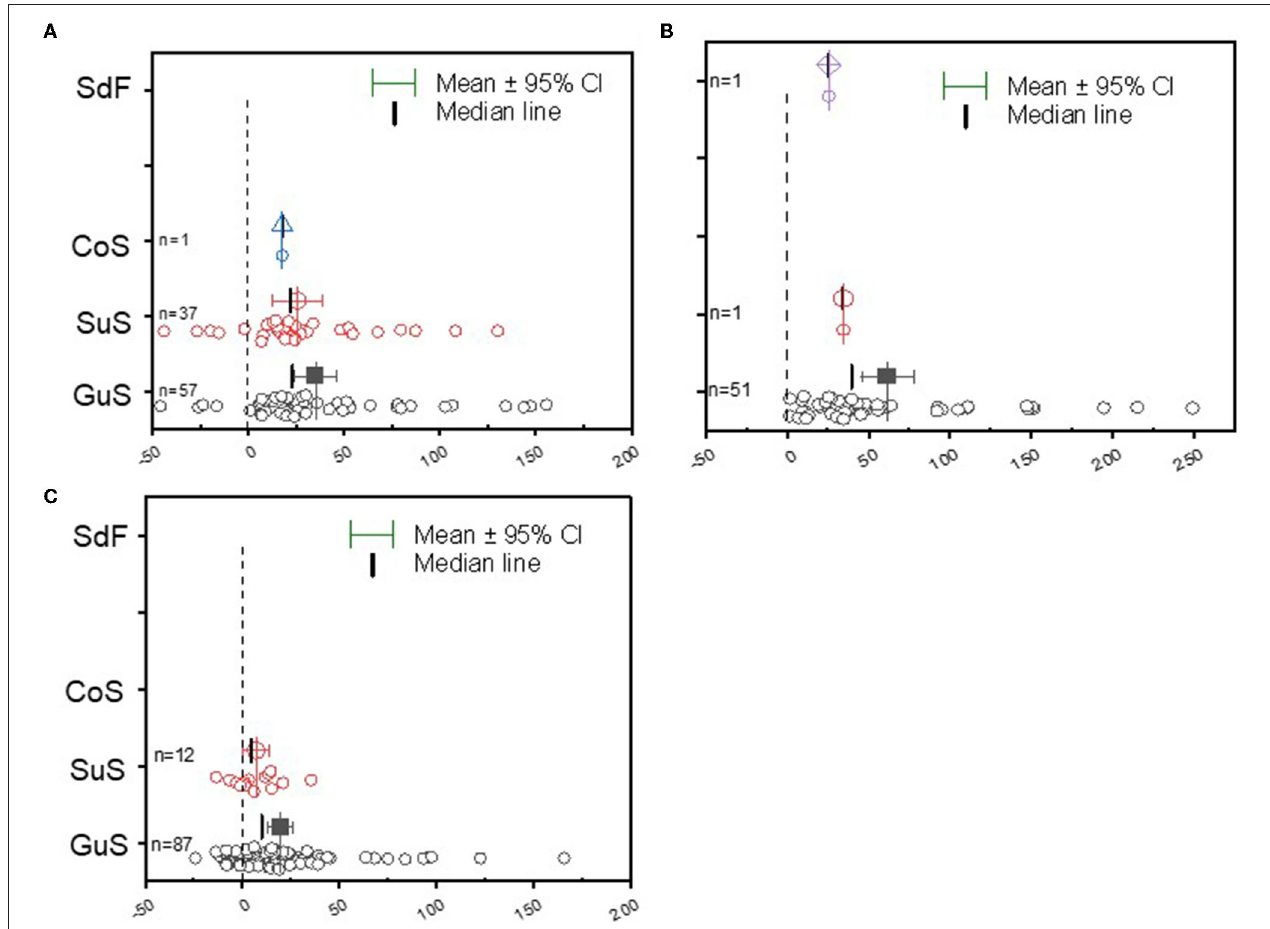
FIGURE 1 | Boxplot and scatter data (open circle symbol) of the relative increase in grain yield of (A) soybean, (B) cowpea, and (C) groundnut to rhizobia inoculation compared to the uninoculated control plants in the Guinea savanna (GuS), Sudan savanna (Sus), Coastal savanna (Cos), and semi-deciduous forest (SdF) agroecological zones of Ghana. The mean values (different symbols) with a 95% bootstrap confidence interval, the median line, and the sample size ( n ) are shown.